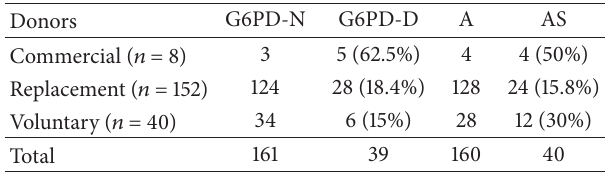
Table 3: Types of blood donors with G6PD and haemoglobin variants distribution.